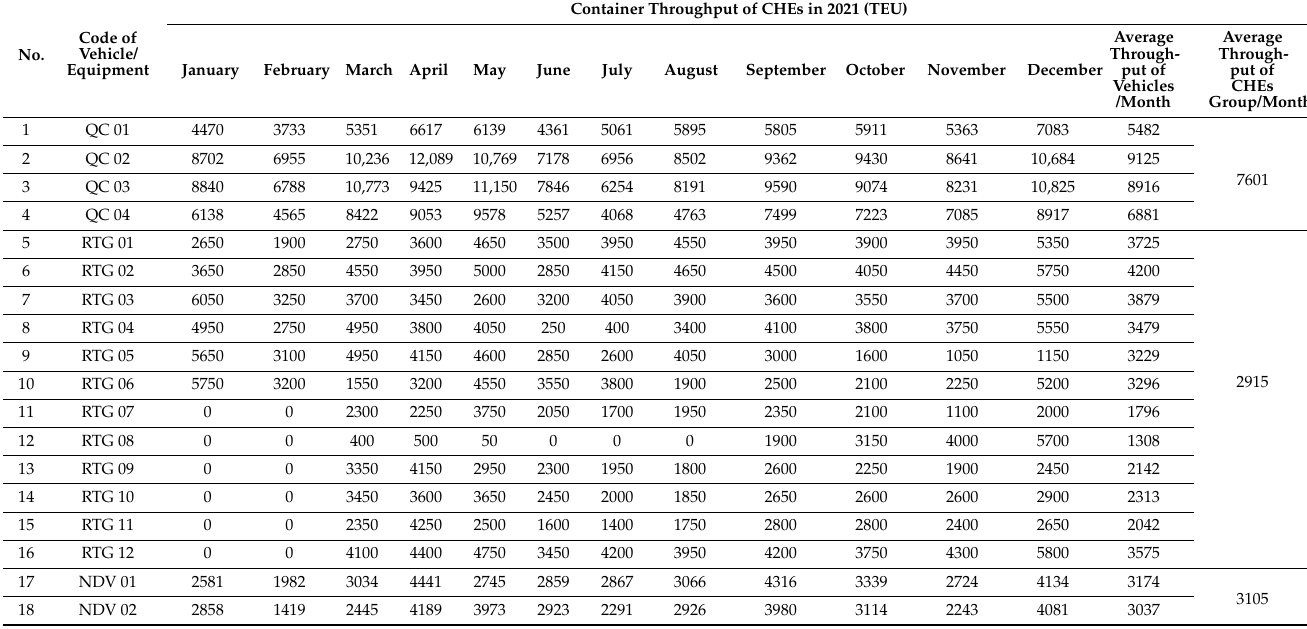
Table 4. Container throughput of CHEs in Nam Dinh Vu terminal in one year (12 months).